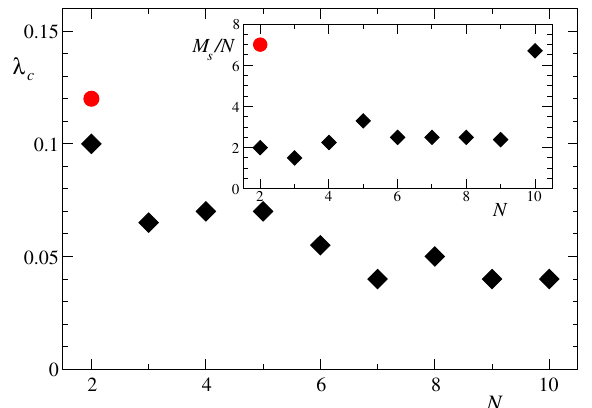
FIG. 8. Hartree-Fock results (black diamonds) for the critical interaction strength λ c vs particle number N for α ¼ 30 (main panel). The red circle shows the corresponding exact- diagonalization result for N ¼ 2 . Inset: Magnetization M s (in units of ℏ N ) found for λ ≳ λ c vs particle number N